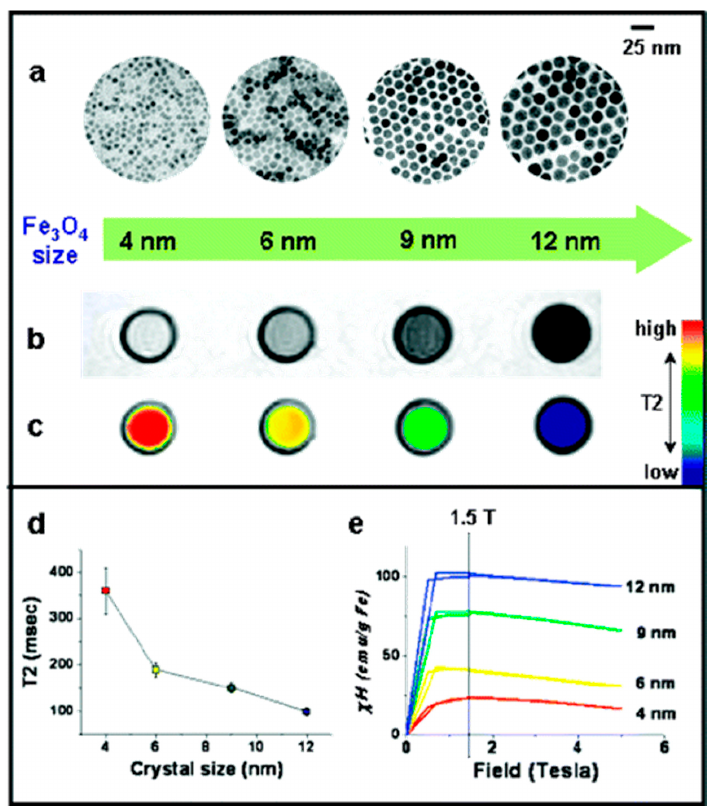
Figure 2. Nanoscale size effect of nanocrystals on magnetism and induced Magnetic Resonance (MR) signals. ( a ) Transmission Electron Microscope (TEM) images of Fe 3 O 4 nanocrystals of 4 to 6, 9, and 12 nm. ( b ) Size-dependent T 2 -weighted MR images of nanocrystals in aqueous solution at 1.5 T. ( c ) Size-dependent changes from red to blue in color-coded MR images based on T 2 values. ( d ) Graph of T 2 value versus nanocrystal size. ( e ) Magnetization of nanocrystals measured by a superconducting quantum interference device (SQUID) magnetometer. Reproduced from “Nanoscale size e ff ect of magnetic nanocrystals and their utilization for cancer diagnosis via magnetic resonance imaging”, with permission from American Chemical Society,